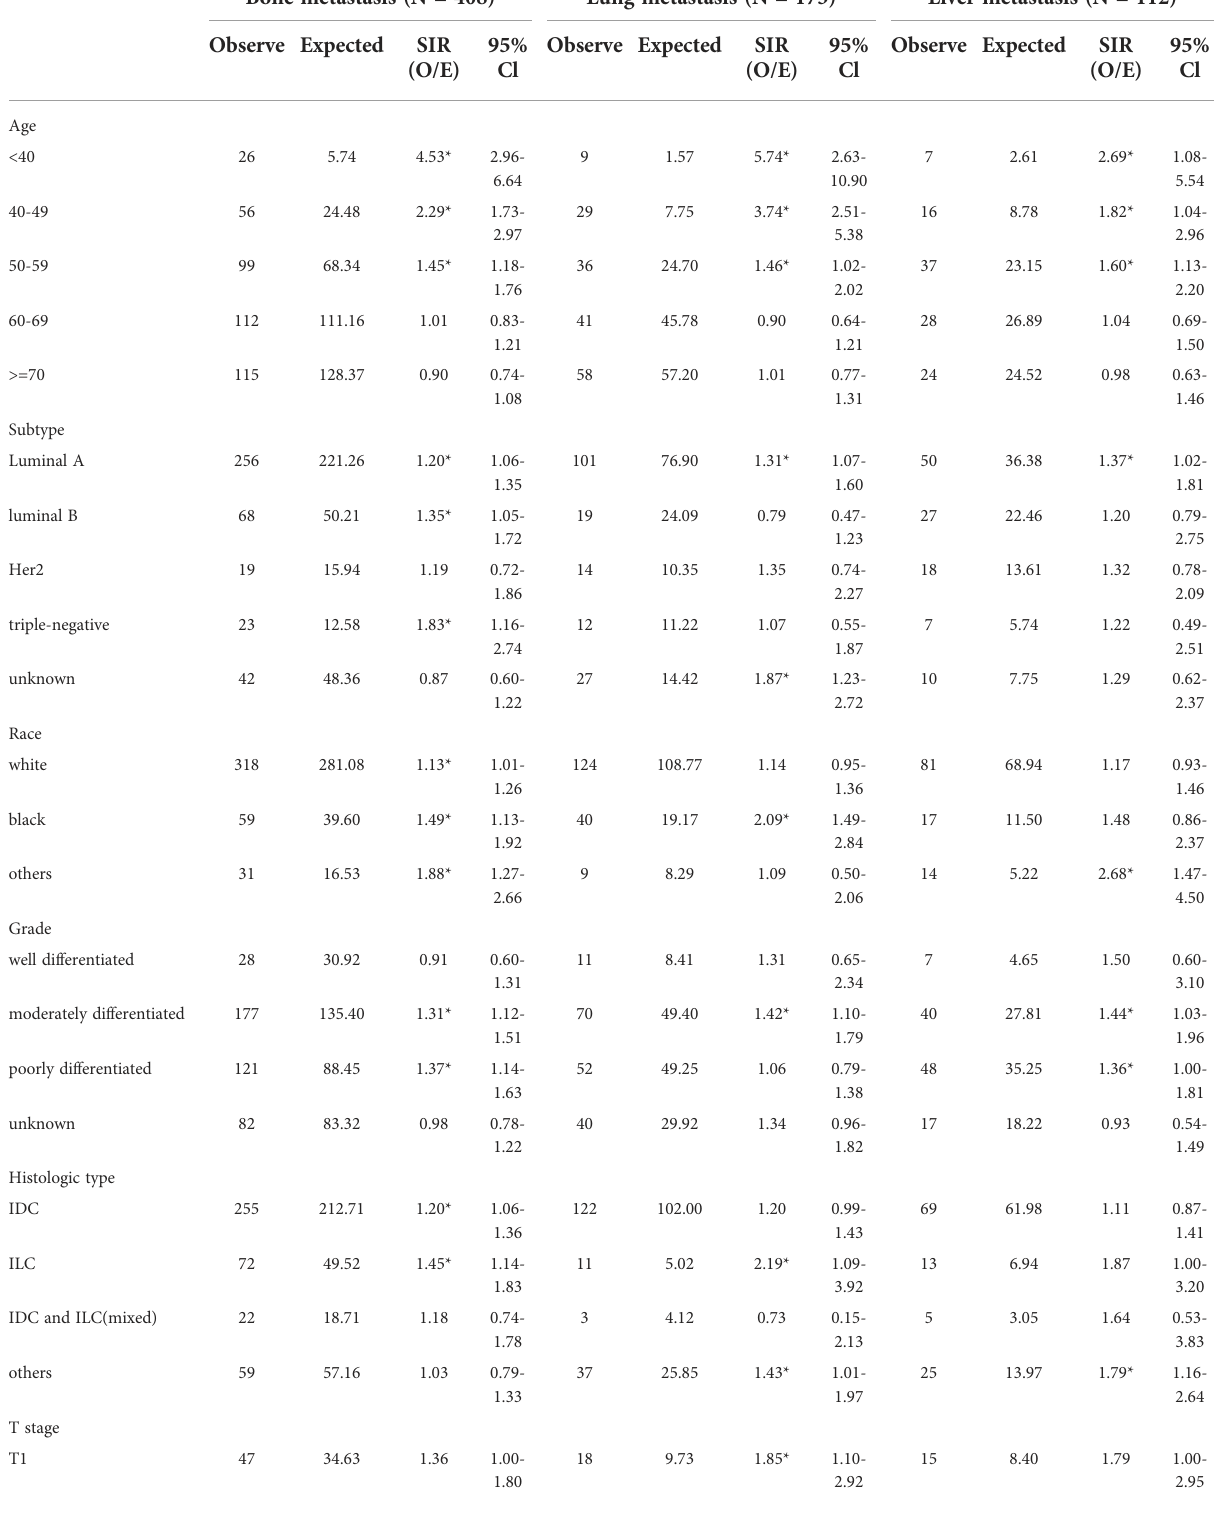
TABLE 2 Standardized incidence ratios of SPCs in distant MBC patients by characteristics. Bone metastasis (N = 408) Lung metastasis (N = 173) Liver metastasis (N = 112) Observe Expected SIR 95% Observe Expected SIR 95% Observe Expected SIR (O/E) Cl (O/E) Cl